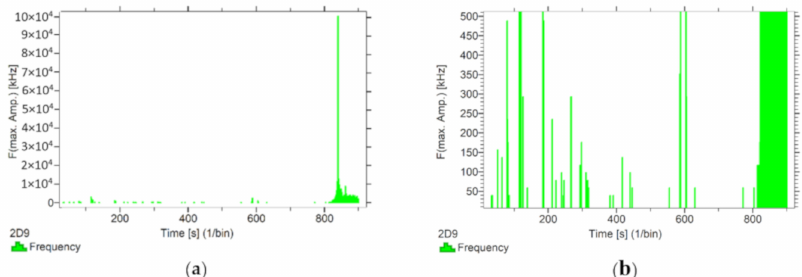
Figure 9. Frequency distribution graph during the test of the mock BW sample: ( a ) taking into account the entire frequency range; ( b ) specifying the frequency range before destruction.